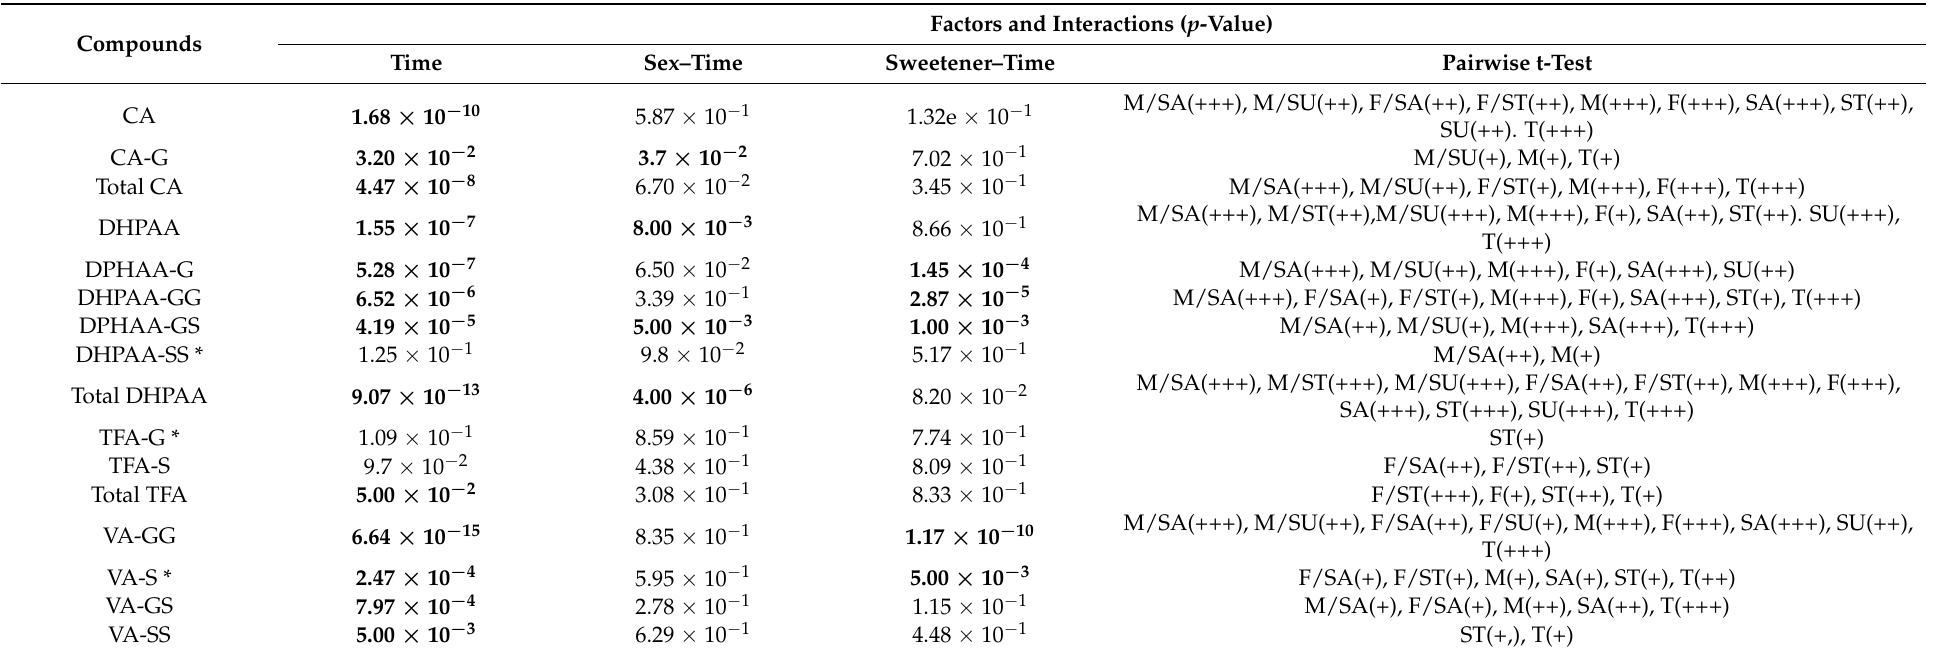
Table 1. p -value for the ANOVA and pairwise t-test analysis of plasma-anthocyanin results. In bold, those p -values < 0.05 from ANOVA. In the t -test results, (+) means a positive relation. More than one symbol indicates a higher grade of relation, based on a p -value < 0.01 for (++) and p -value < 0.001 for (+++). CA-sulfate was excluded for not showing significant results, either in ANOVA or in the t -test. Abbreviations: M, male; F, female; SA, sucrose; SU, sucralose; ST,